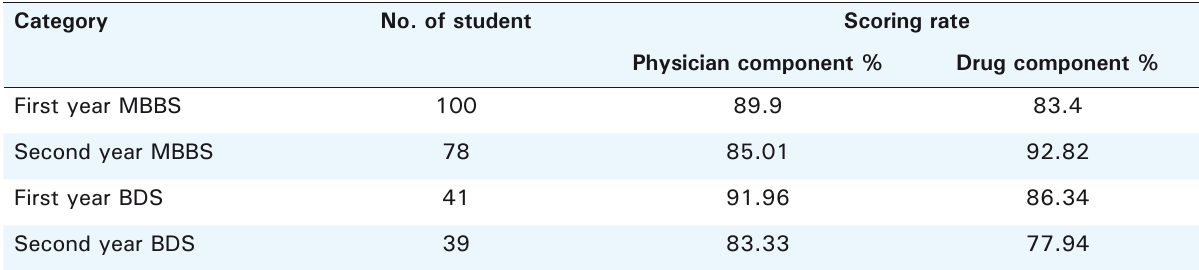
table 3. Comparison of scoring rate of different component of prescription between years of MbbS and